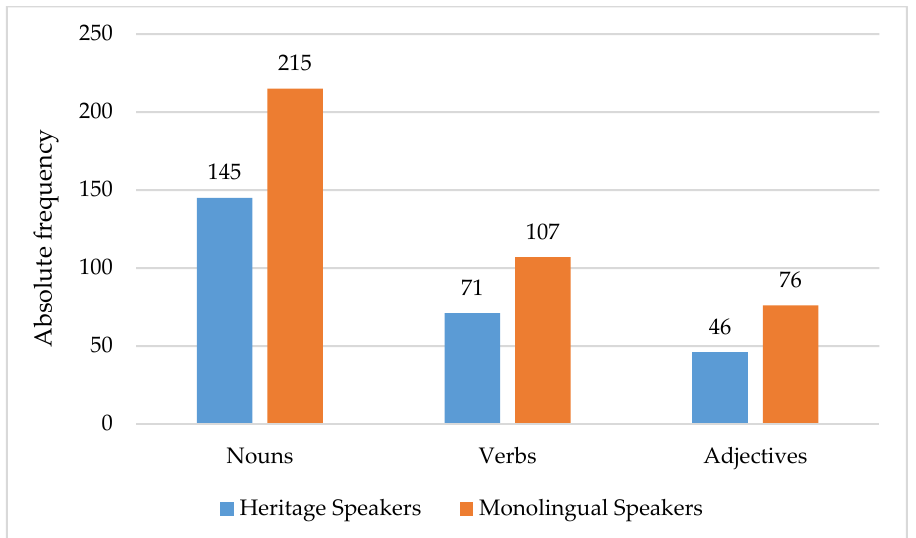
Figure 1. Quantity of lexical items produced in each grammatical category per group of European Portuguese (EP) speakers.